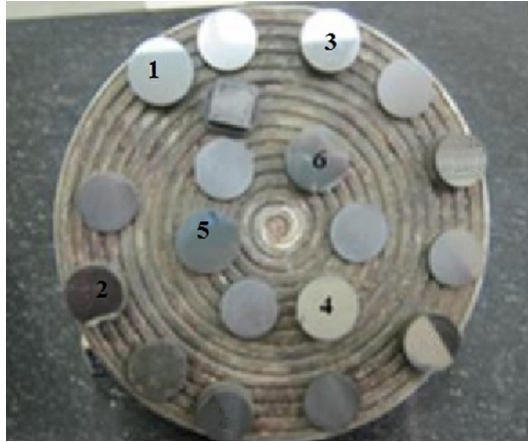
Figure 8. Photo of numbered workpieces of α-SiC and β-SiC.